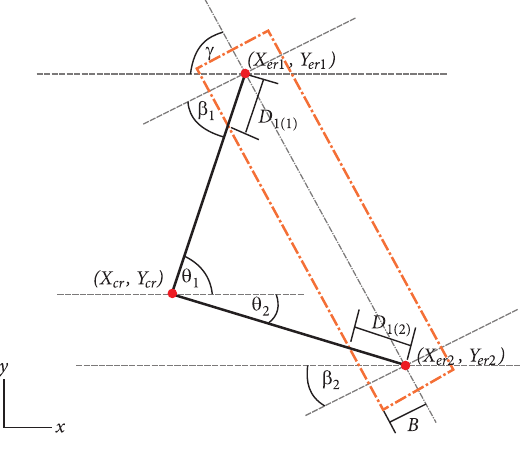
Fig. 6. Estimation of effective widths